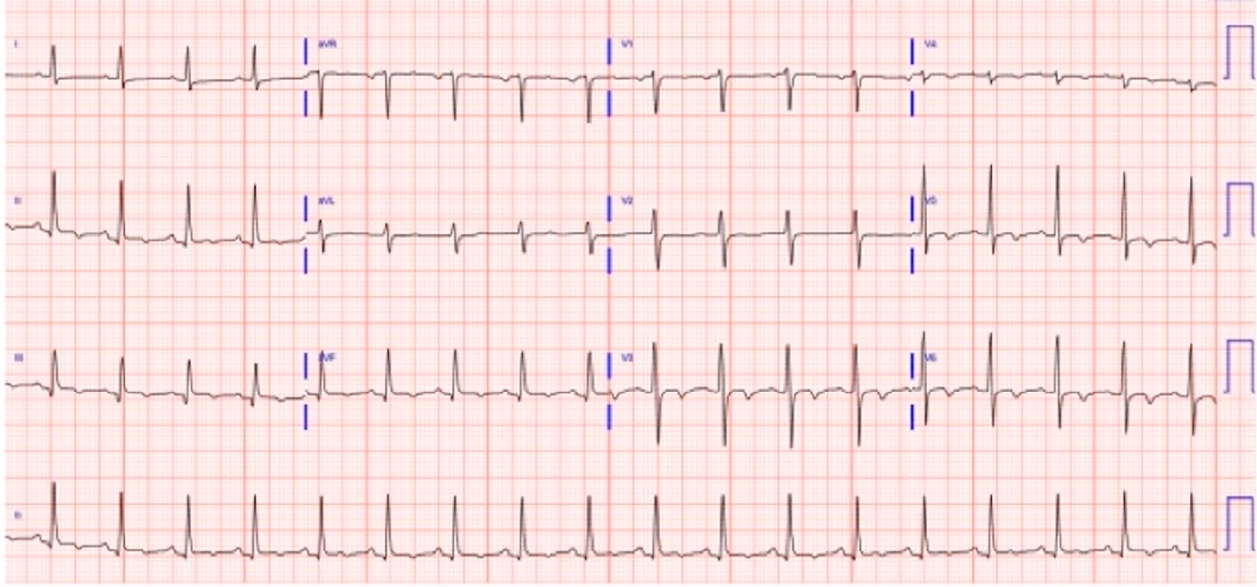
Figure 1. Twelve-lead Electrocardiogram showing sinus tachycardia and “S1Q3T3” pattern of acute cor pulmonale. Note S wave in lead I, a Q wave in lead III, and an inverted T wave in lead III indicate acute right heart strain.